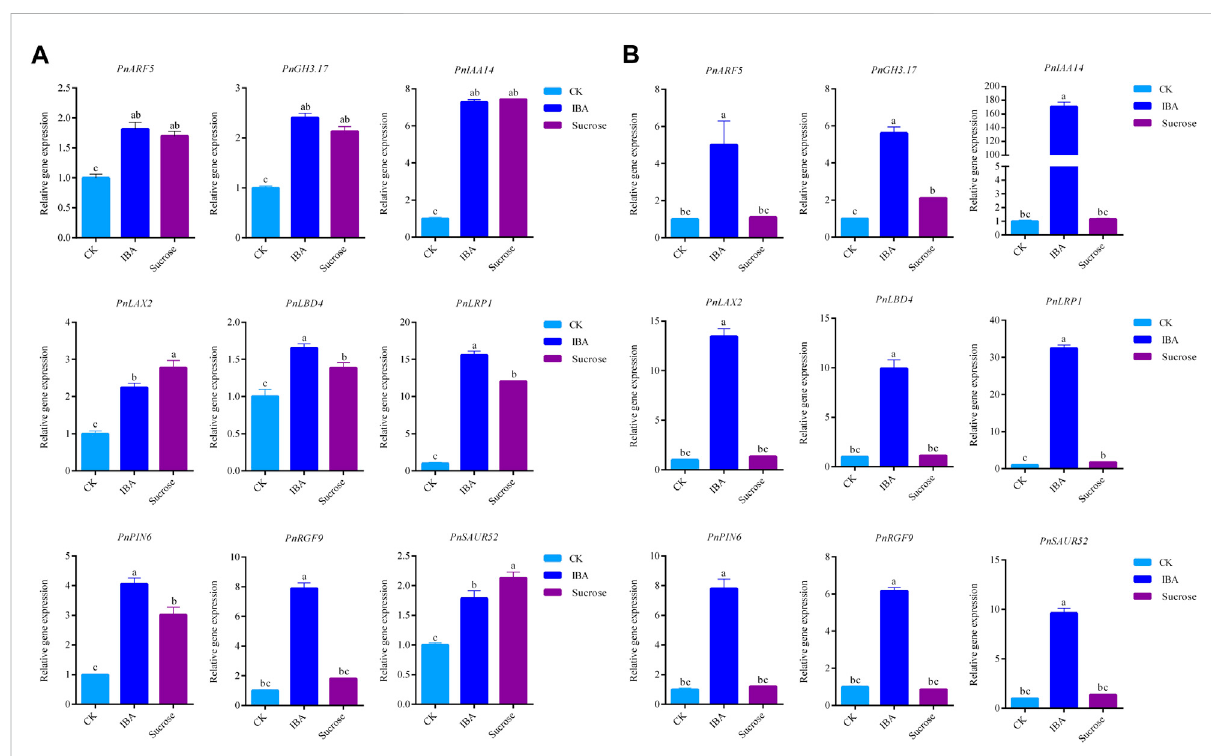
FIGURE 6 qRT-PCR results of PnARF5 , PnGH3.17 , PnIAA14 , PnLAX2 , PnLBD4 , PnLRP1 , PnPIN6 , PnRGF9 , and PnSAUR52 under the exogenous IBA or sucrose were applied: (A) applied for 2 days and (B) applied for 4